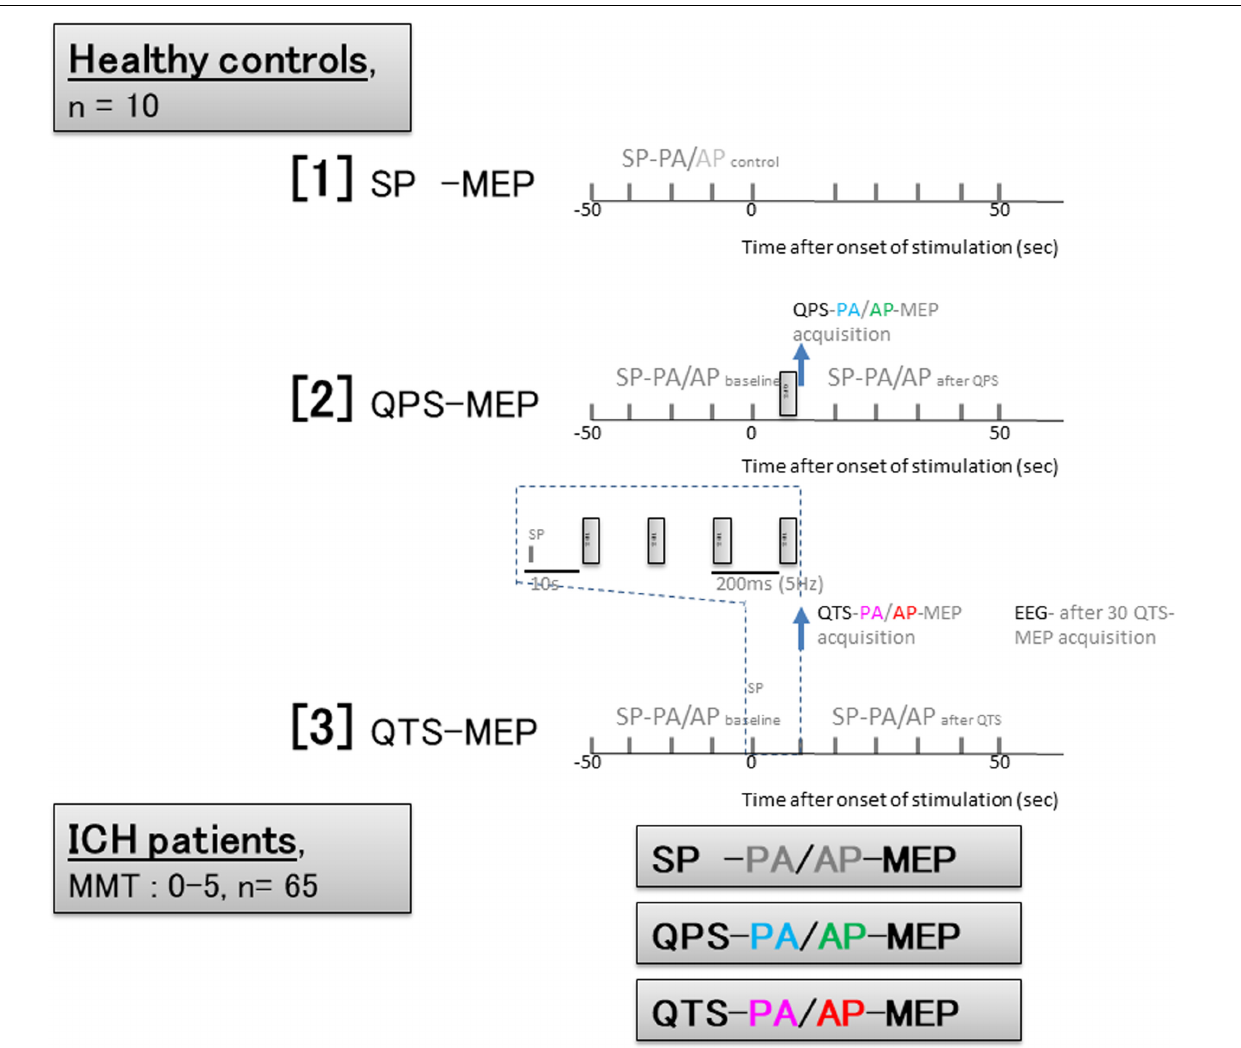
FIGURE 2 | Experimental protocol based on time series configurations for healthy controls and patients with ICH. Healthy controls; [1] Ten SP-PA and AP- motor evoked potential (MEP) were recorded every 10 s. [2] quadripulse theta burst stimulation (QPS)- and QTS-PA and AP-MEPs were recorded every 110 s. [3] QTS-MEP acquisitions were triggered from the beginning of the first burst and continued to the end of the fourth and final burst to verify MEP amplification in QTS during four-burst theta rhythm stimulations (analysis window of 800 ms; dark blue dashed box). SP-PA or AP-MEPs were recorded every 10 s before and after 50 s. QTS-MEPs after the fourth burst were measured to detect RMT and measure amplitude and latency. Electroencephalograms (EEGs) were recorded for ≥ 30 min post-recording in 10 participants after 30 QTS. Patients with ICH; Trigger for MEP acquisition: QTS-MEP after the fourth burst, QPS-MEP after single burst, and SP-MEPs were measured to detect RMT and measure amplitude and latency in each patient. Sessions without stable recording after 30 trials were